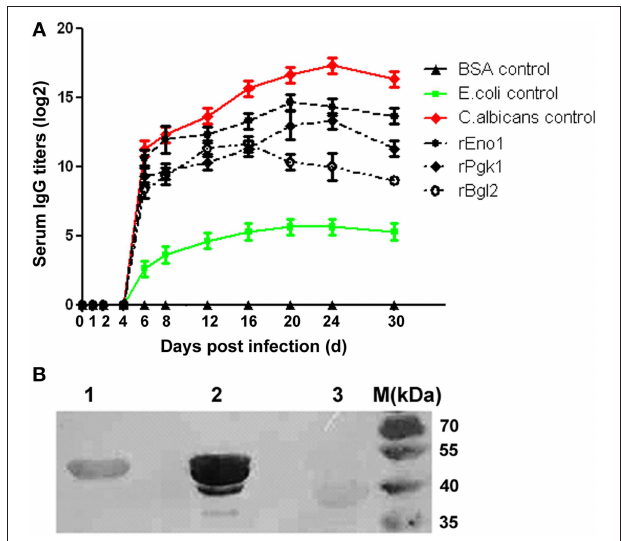
FIGURE 3 | Serological response of C. albicans infected mice to recombinant protein Eno1, Pgk1, and Bgl2. (A) The kinetics of IgG antibody titers to rEno1, rPgk1, and rBgl2 were measured by ELISA, mice sera were 1:100 pre-diluted before detection. Protein extract of C. albicans was used as positive control, and protein extract of E. coli and BSA were used as negative controls. (B) Using the mixed mice sera collected from the 20th and 24th day post infection as the first antibody (1:400 pre-diluted), Western-blot show rEno1 possess the strongest immunoreactivity, followed by rPgk1 and